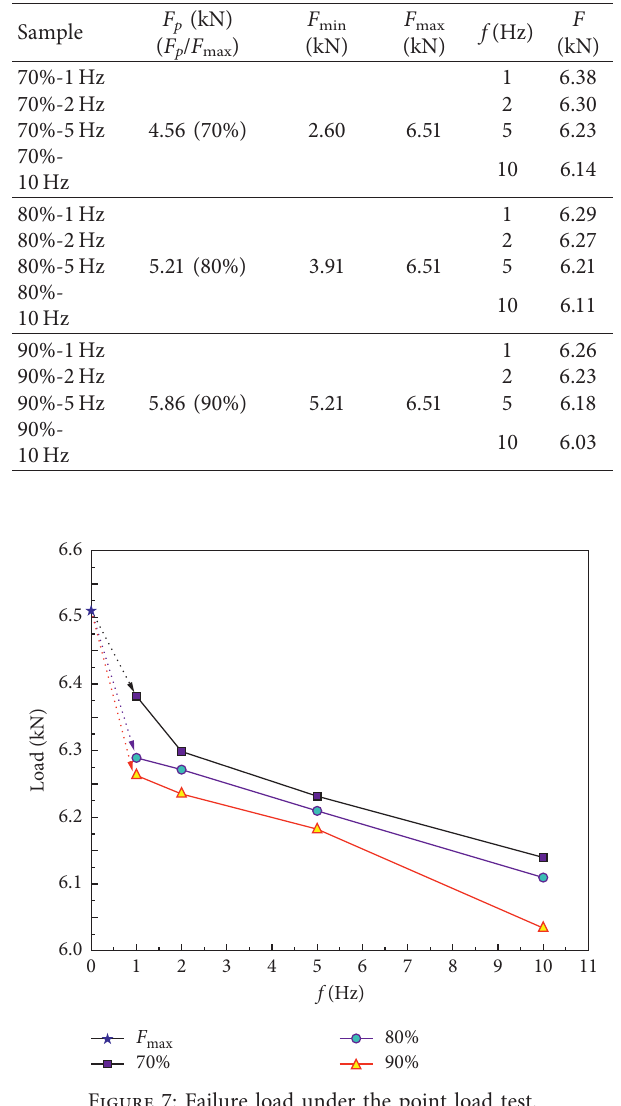
Figure 7: Failure load under the point load test.